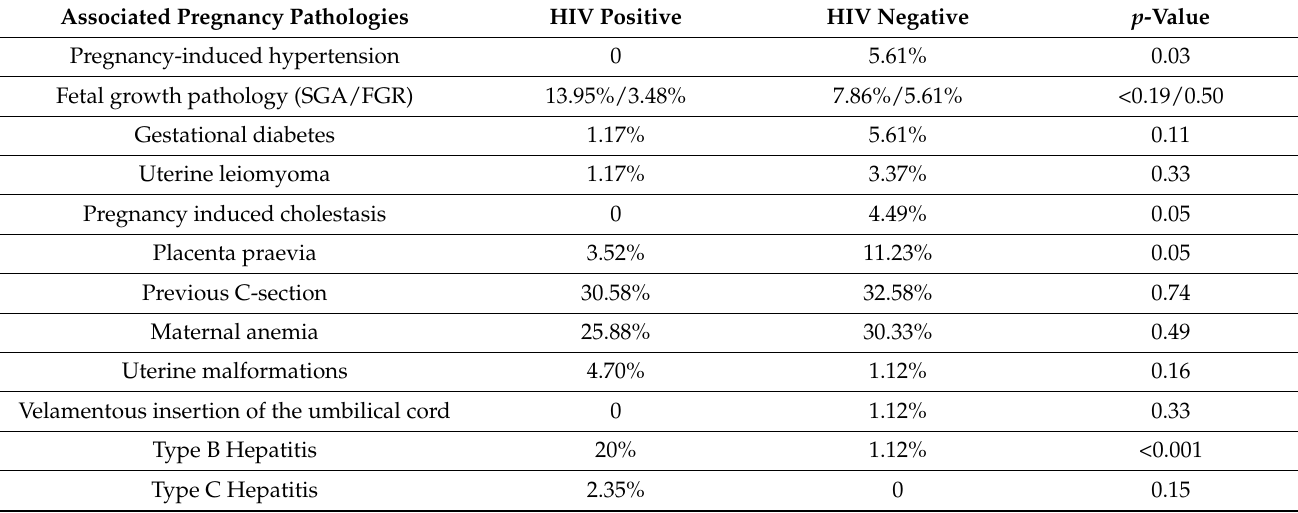
Table 4. Associated pregnancy pathologies and statistical